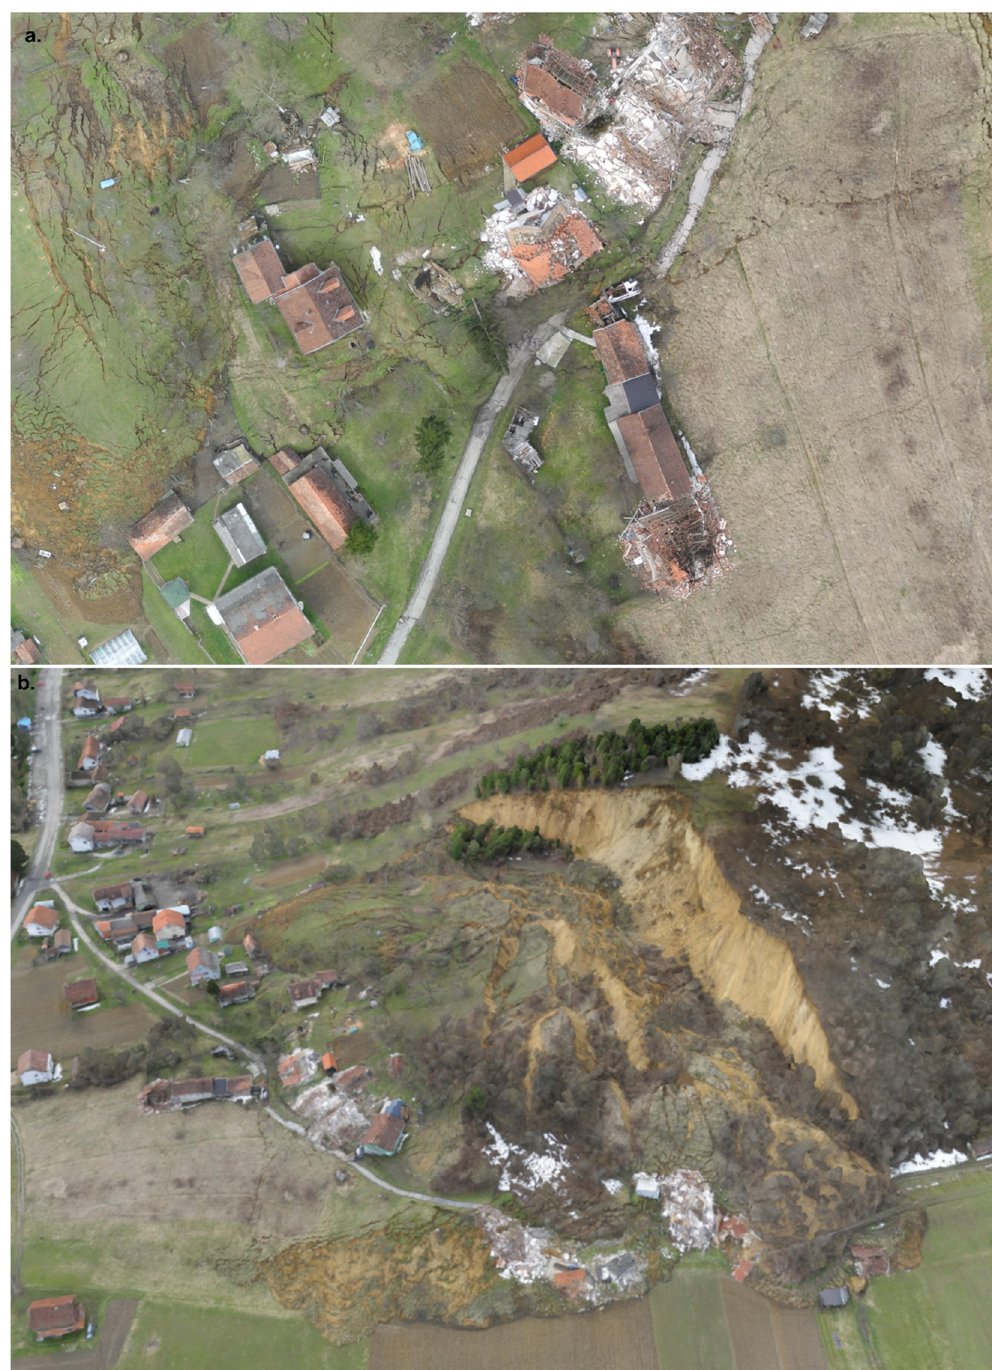
Figure 6. Hrvatska Kostajnica landslide area on 14 March 2018 (day after the event)—UAV data collected, analysed and developed by CGS: ( a ) detailed orthophoto data; and ( b ) 3D landslide area spatial model.